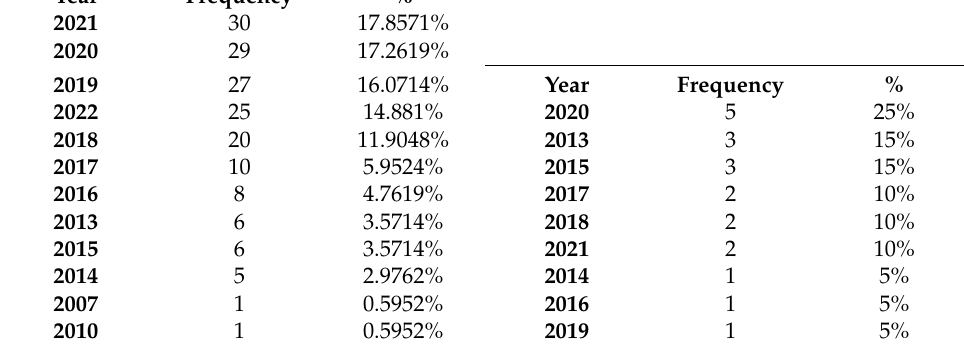
Table 1. List of high frequency publication years of “BIM” and “architectural heritage” articles (167 articles listed on the left and 20 high-level articles listed on the